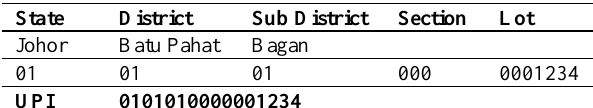
Table 1. Example of UPI code structure